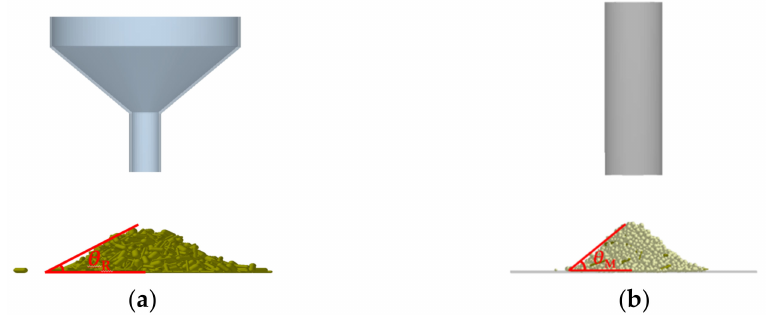
Figure 10. The AOR simulation test of SMR and MRSM. ( a ) SMR; and ( b )